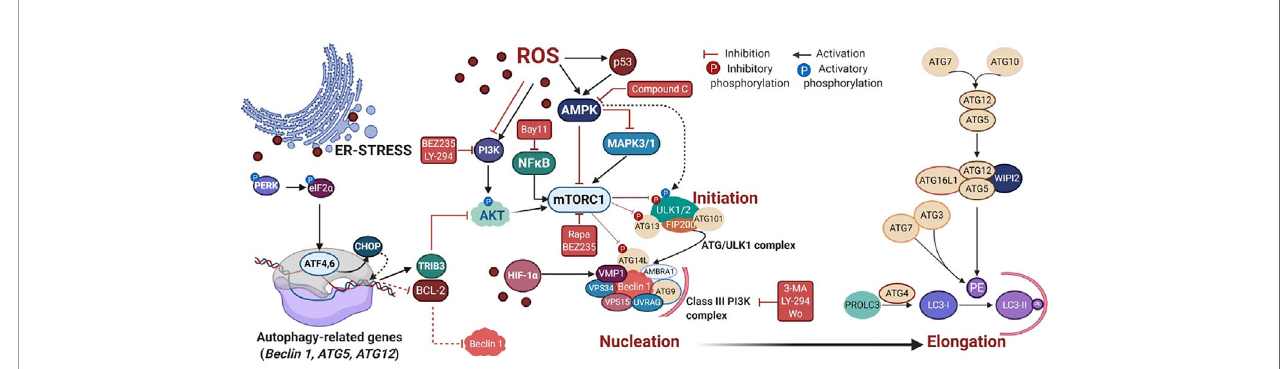
FIGURE 3 | PDT-mediated autophagy regulation in mammalian cells. The reactive oxygen species (ROS)-mediated mechanism covers the autophagy regulation via several signaling cascades, including the energy-sensing AMPK and the PI3K/AKT/mTOR pathways. Following mTOR inhibition, the autophagy initiation starts through the activation of the ATG/ULK1 complex that translocates to the ER membrane and recruits ATG9, providing membrane components to the phagophore (130, 131). ULK1 complex can also be alternatively activated by AMPK (132, 133). In the nucleation process, following activation of the Class III PI3K complex I, occurs the production of phospholipid phosphatidylinositol3-phosphate (PI 3 P) which recruits PI 3 P-binding proteins (e.g. WIPI2), resulting in the change of the ER membrane structure with its elongation to form a phagophore (134). The elongation step relies on the generation of the soluble cytosolic LC3-I that becomes LC3-II after conjugation to the head group of the lipid phosphatidylethanolamine (PE), which occurs through a cascade of ubiquitin-like reactions involving ATG enzymes (e.g. ATG7, ATG3, and ATG5-ATG12-ATG16L). Next, LC3-II is attached to the lumenal and cytosolic surfaces of autophagosomes. The drug mediators that activate (BEZ235, rapa, and LY-294) or inhibit (3-MA, compound C and wo) autophagy machinery are depicted in red. Rapa = rapamycin, LY-294 = LY-294002, wo = wortmannin. Picture created with BioRender.com.